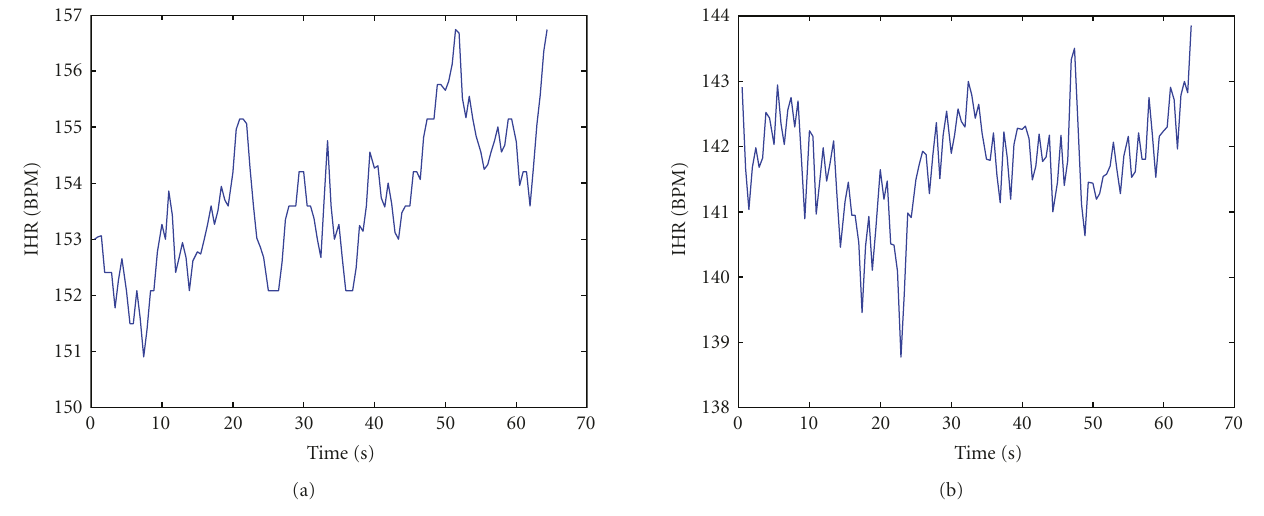
Figure 1: The HRV related to (a) nonseizure EEG and (b) seizure